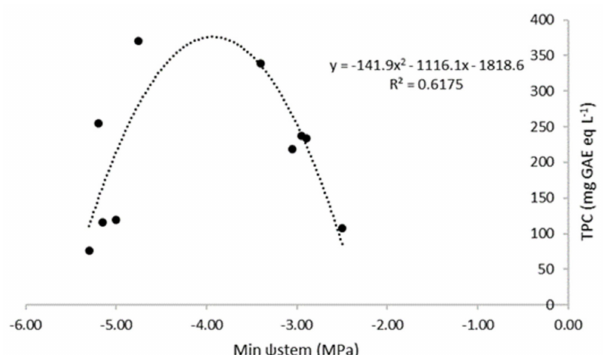
Figure 1. Quadratic correlation between total phenolic content (TPC (mg GAE eq L − 1 )) and minimum midday stem water potential (Min ψ stem (MPa)). Data shown in this figure are the mean of 12 replications per irrigation treatment.